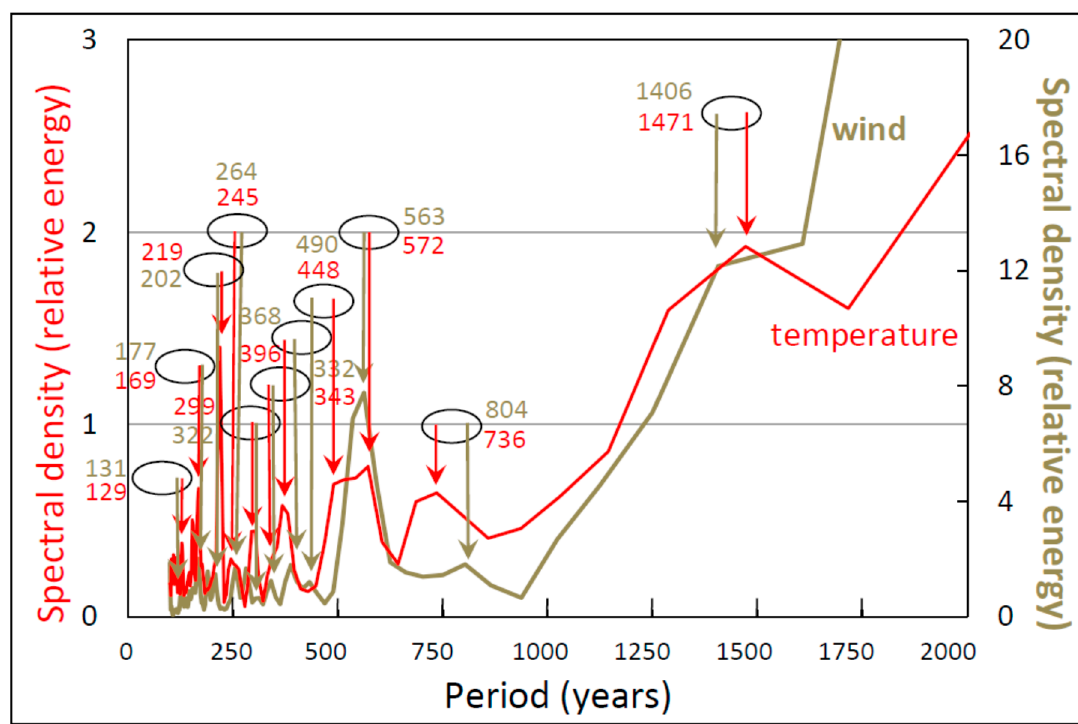
Figure 13. Spectral density periodograms showing similar spectral profiles of dust flux at EPICA Dome C (EDC, brown curve) and temperature proxy at Vostok (red curve) for the glacial period of ~75-65 thousand years before 1950 (Kyb1950). Ovals enclose shafts of arrows that identify the most closely matched peaks, with periods in years shown beside each oval. Fischer’s Kappa statistic and corresponding probability that the distribution is discernibly different from white noise are 36.4, and 2.9 × 10 − 7 (temperature record) and 84.10 and p < 1.129 × 10 − 65 (dust-flux record). The